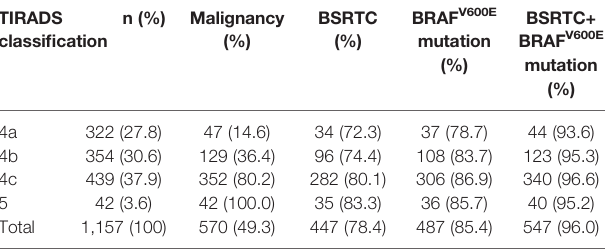
TABLE 2 | Correlations of TIRADS classi fi cation with detection rates of BSRTC and BRAF V600E mutation for